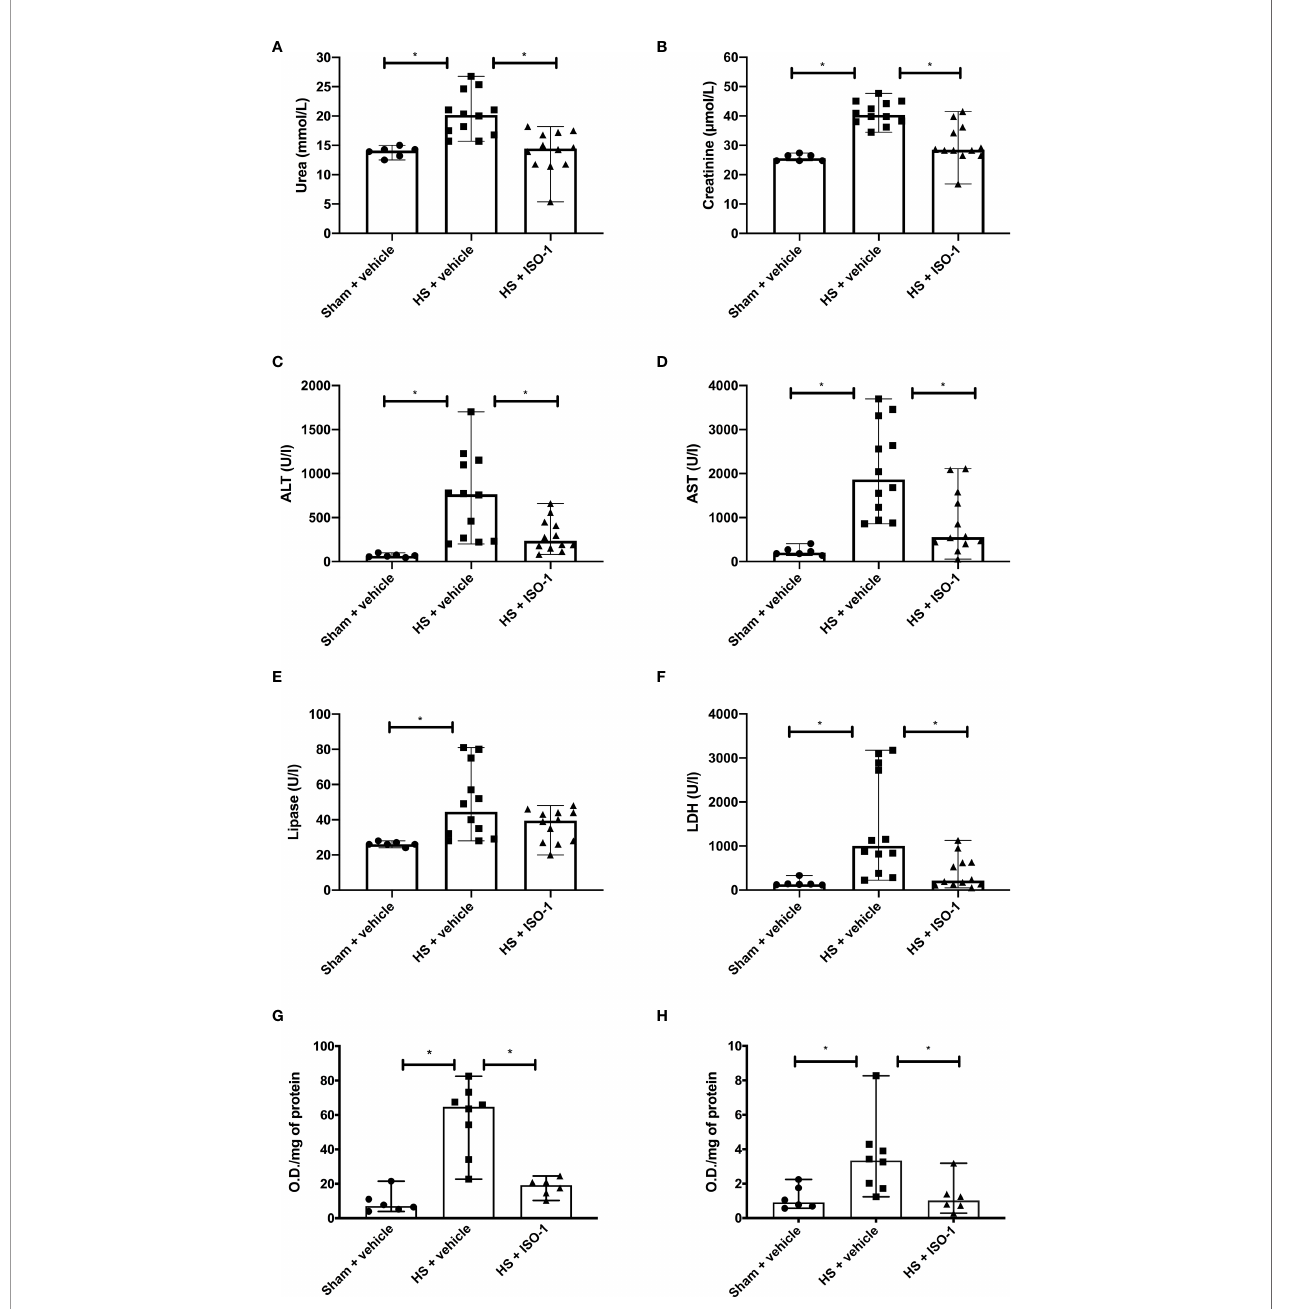
FIGURE 6 | Treatment with ISO-1 attenuates HS-induced organ damage and myeloperoxidase activity in a long-term follow-up acute HS model. Rats were subjected to haemorrhagic shock (HS) and 24 h after resuscitation, levels of serum (A) urea, (B) creatinine, (C) alanine aminotransferase, (ALT), (D) aspartate aminotransferase (AST), (E) lipase and (F) LDH were determined were determined in vehicle and ISO-1 treatedrats. Sham-operatedrats wereusedascontrol. Sham +vehicle(n=6), HS +vehicle(n =12) andHS+ ISO-1(n=12).Myeloperoxidaseactivityin (G) lung and (H) liverweredeterminedfor vehicleandISO-1treatedrats.Sham+ vehicle (n= 6), HS+vehicle(n=8) andHS+ISO-1(n=6).Data areexpressedasmedianwithrange.Statisticalanalysiswasperformedusingone-wayANOVAfollowedbyaBonferroni ’ s post-hoc test.*p<0.05 denotedstatisticalsigni fi